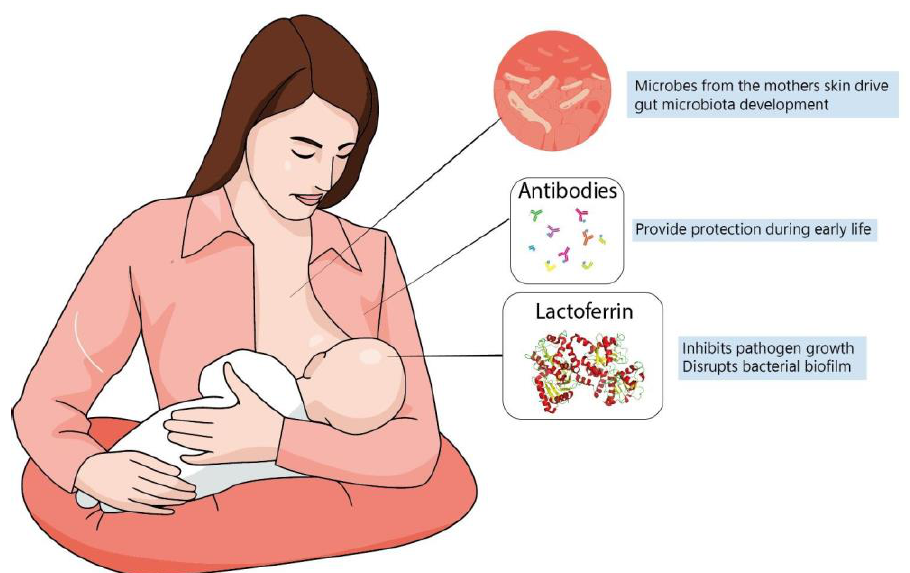
Figure 2. Maternal milk is the optimal source of nutrients for newborns, even in the absence of con- sensus about its ideal composition. Dietary interventions during pregnancy can alter maternal milk composition and alter the infant’s immune system, playing a major role during brain development. The best understanding of molecules present in maternal milk is important not only for improving recommendation directives, but also for defining better formulas to be administered for infants at risk.